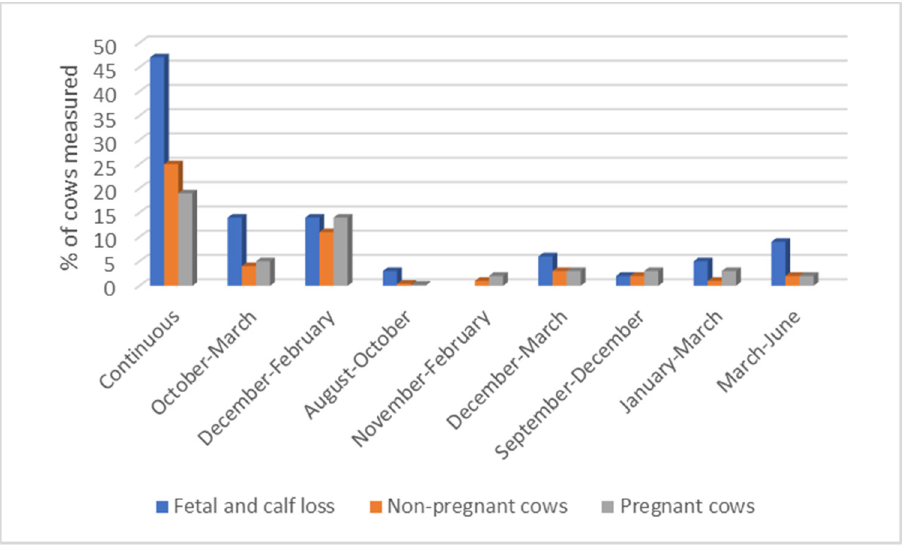
Figure 4. Occurrence of FC, non-pregnant and pregnant cows by breeding season.